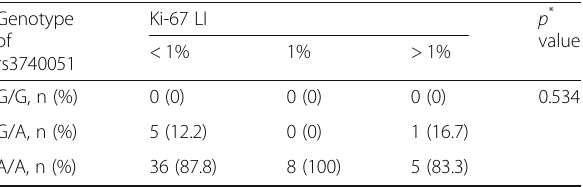
Table 5 Association of Ki-67 LI and rs3740051 in patients with PA Genotype